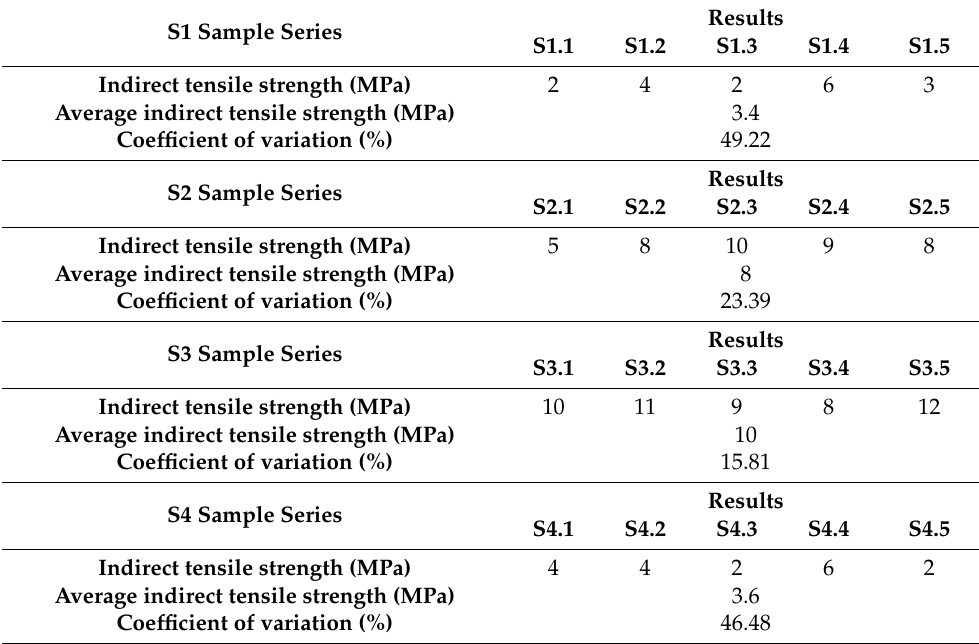
Table 6. Indirect tensile